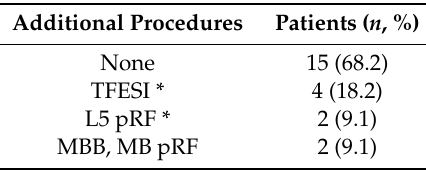
Table 3. Additional interventional procedures in the 6-month follow-up period for the study